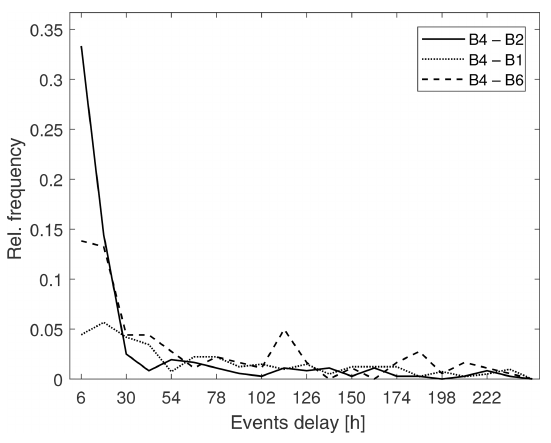
Figure 8. Relative frequency of the events’ delay for B2, B1, and B6. Referring series is that of